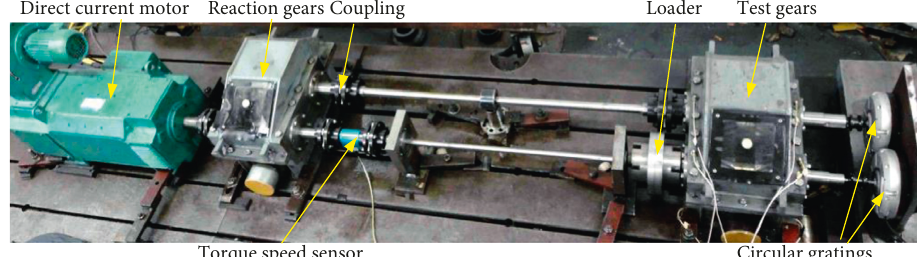
Figure 16: Gear transmission test system to implement proposed measurement scheme.